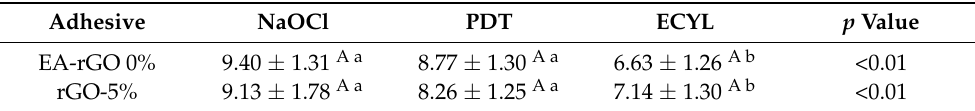
Table 1. Push-out bond strength of surface treated adhesive bonded dentin specimens in the study (values in MPa).